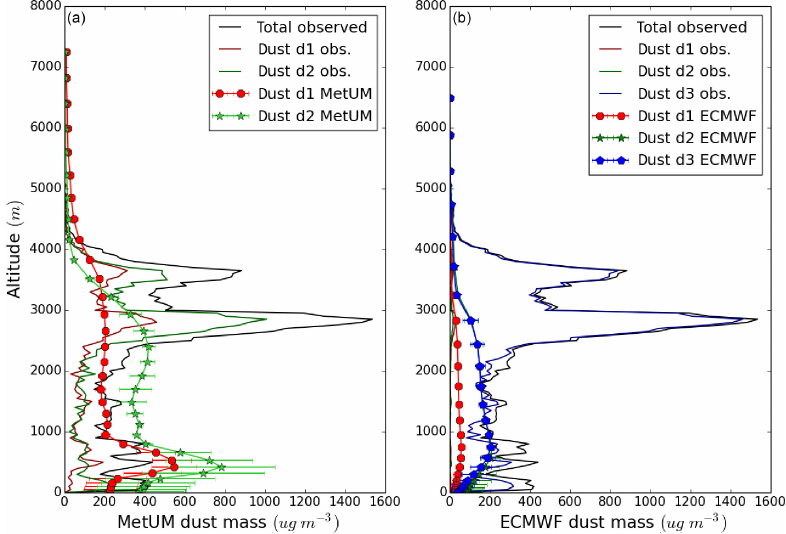
Figure 16. Case study 4: B932, 20 August, P4. (a) Dust concentration measured by the in situ instruments on the aircraft for two MetUM dust divisions 1 (red) and 2 (green), as well as the total dust concentration measured (black). The division 1 and 2 concentration from the model is shown in a lighter shade of red and green, respectively, with markers and error bars showing the standard deviation. (b) The right-hand plot shows the same thing but for the ECMWF–CAMS size bins, with the measurements shown using lines and the model values with lines and markers for divisions 1 (red), 2, (green), and 3